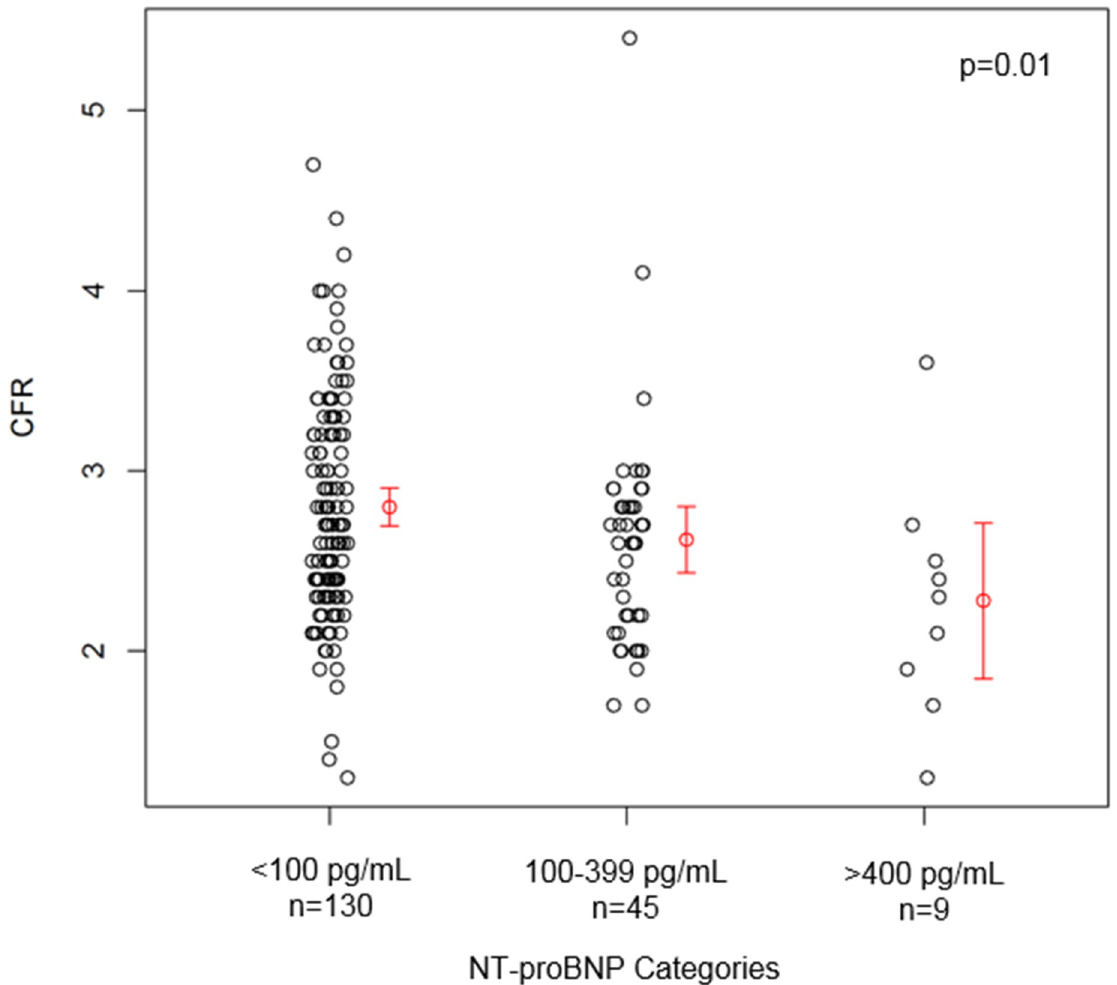
Fig 1. Scatter plot of CFR by NT-proBNP categories. Mean and 95% confidence interval for the mean of each category in red (Kruskal- Wallis test, p = 0.01) (total n = 184).